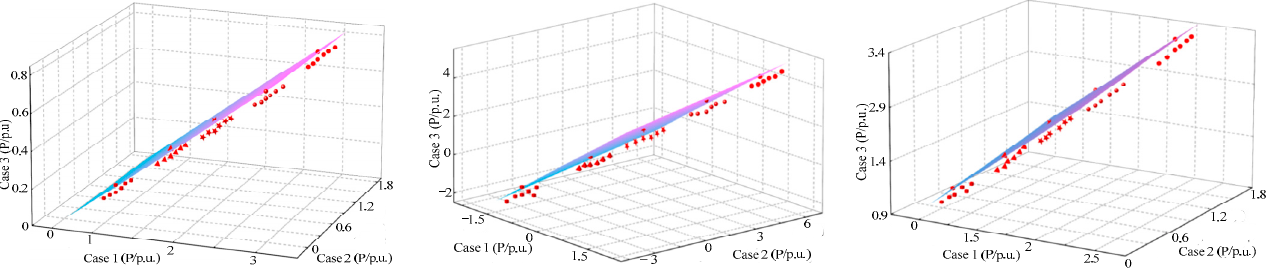
Figure 14. Sensitivity analysis of DSSR in three cases (Case 1: Santanghu station; Case 2: Hami station; Case 3: Yandun station).